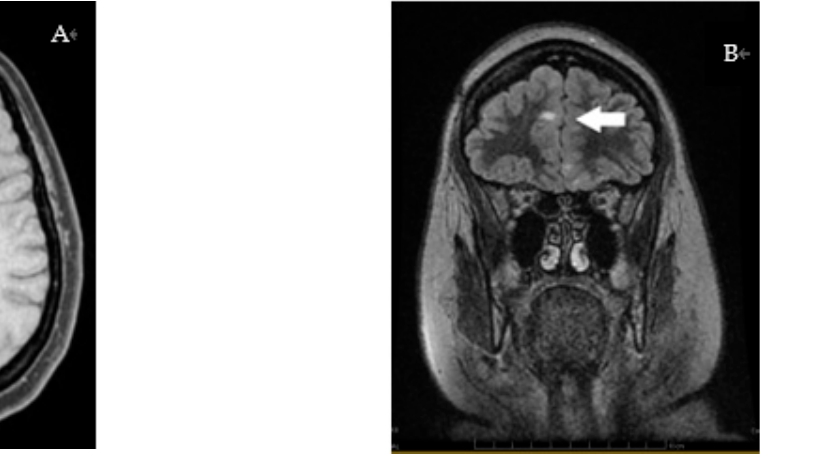
Figure 4. Brain MRI: ( A ) Subependymal nodules; ( B ) Frontal cortico-subcortical tubers.